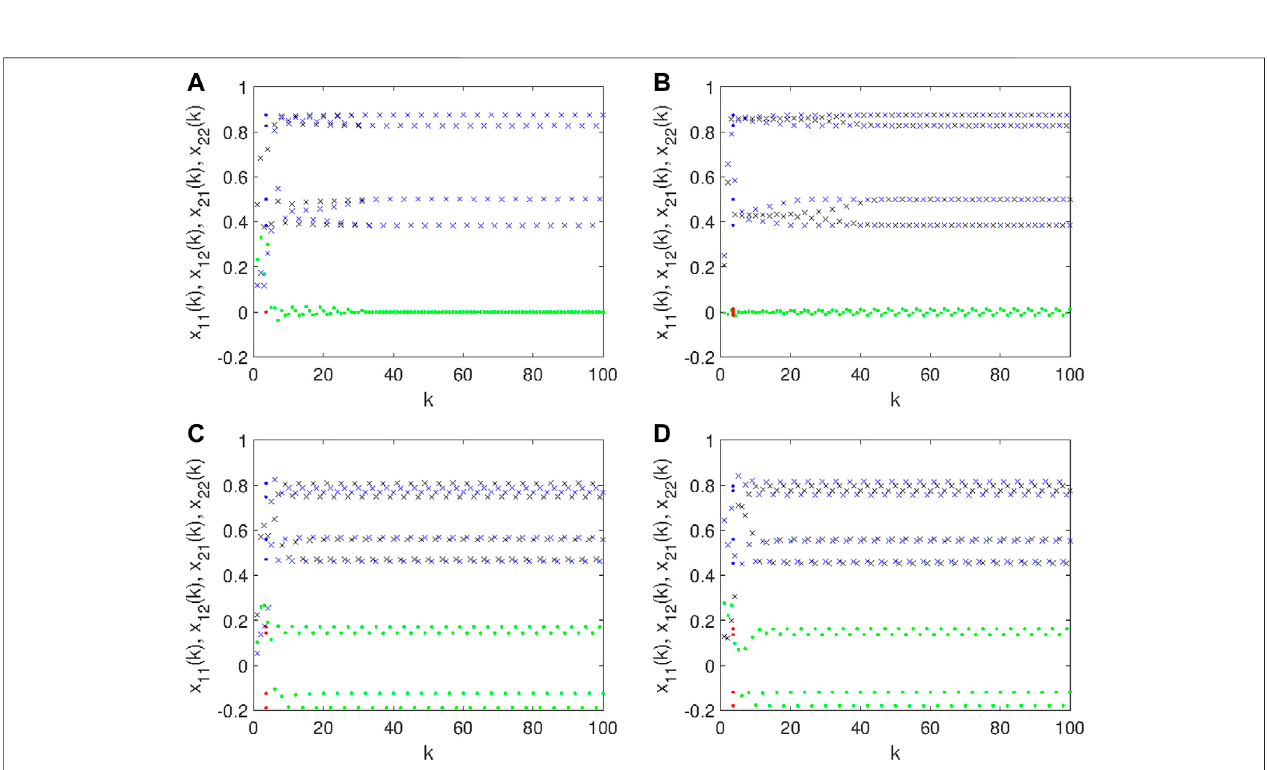
FIGURE6| Differentperiodicbehaviorofthemultidimensionallogisticmapin Eq.16 with N =2and a =3.5: (A) In-phaseperiodicityofthediagonalmaps x 11 ( k )and x 22 ( k ) leading to convergent off-diagonal maps x 12 ( k ) and x 21 ( k ); (B – D) not in-phase periodicity of the diagonal maps x 11 ( k ) and x 22 ( k ) leading to period-4 behavior also in the off-diagonal maps x 12 ( k ) and x 21 ( k